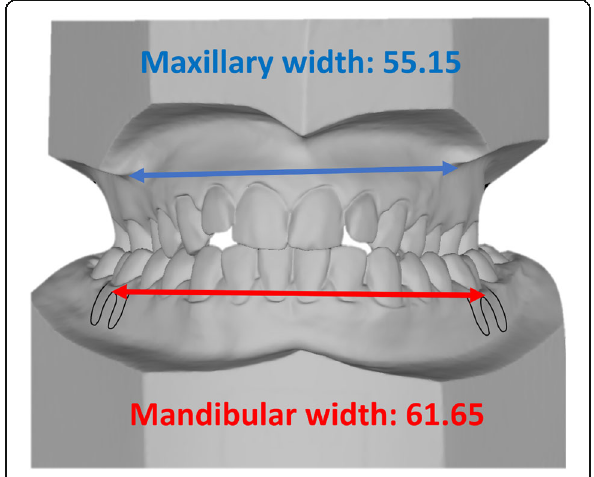
Fig. 2 Method used in dental casts to project the extent of maxillary skeletal expansion required. Blue line, maxillary width, and red line, mandibular width measured with a digital caliper; Mandibular width is defined as the distance between the right and left gingiva tissue projected at the level of first mandibular molar ’ s furcation. In this case, the transverse deficiency in models accounts for 6.5